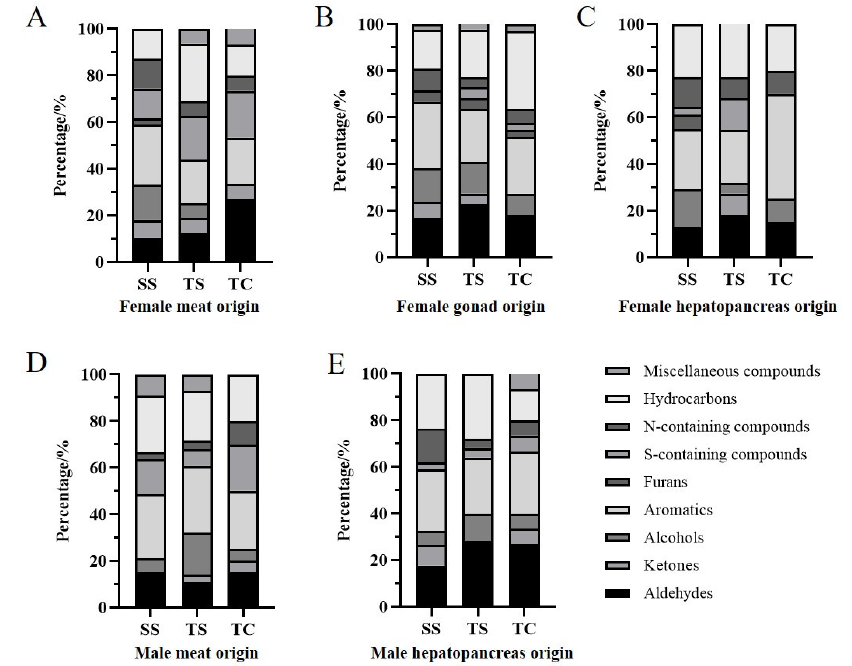
Figure 1. Categories of volatile compounds identified in edible parts of E. sinensis from regions. ( A ), ( B ), and ( C ) representing female meats, gonads, and hepatopancreas, respectively. ( D ) and ( E ) represent male meats and hepatopancreas, respectively.